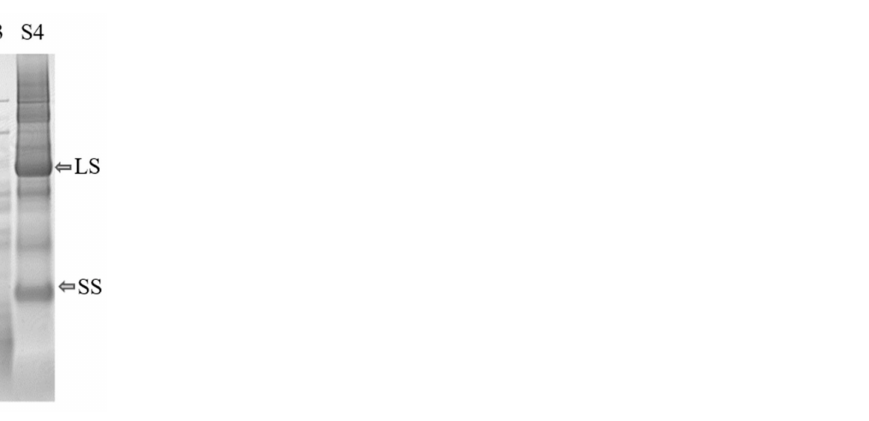
Figure 4. Protein content in mangold leaves, as determined by SDS-PAGE analysis of supernatants S1–S4 from the extraction process (see Figure 2). LS: large subunit, SS: small subunit of